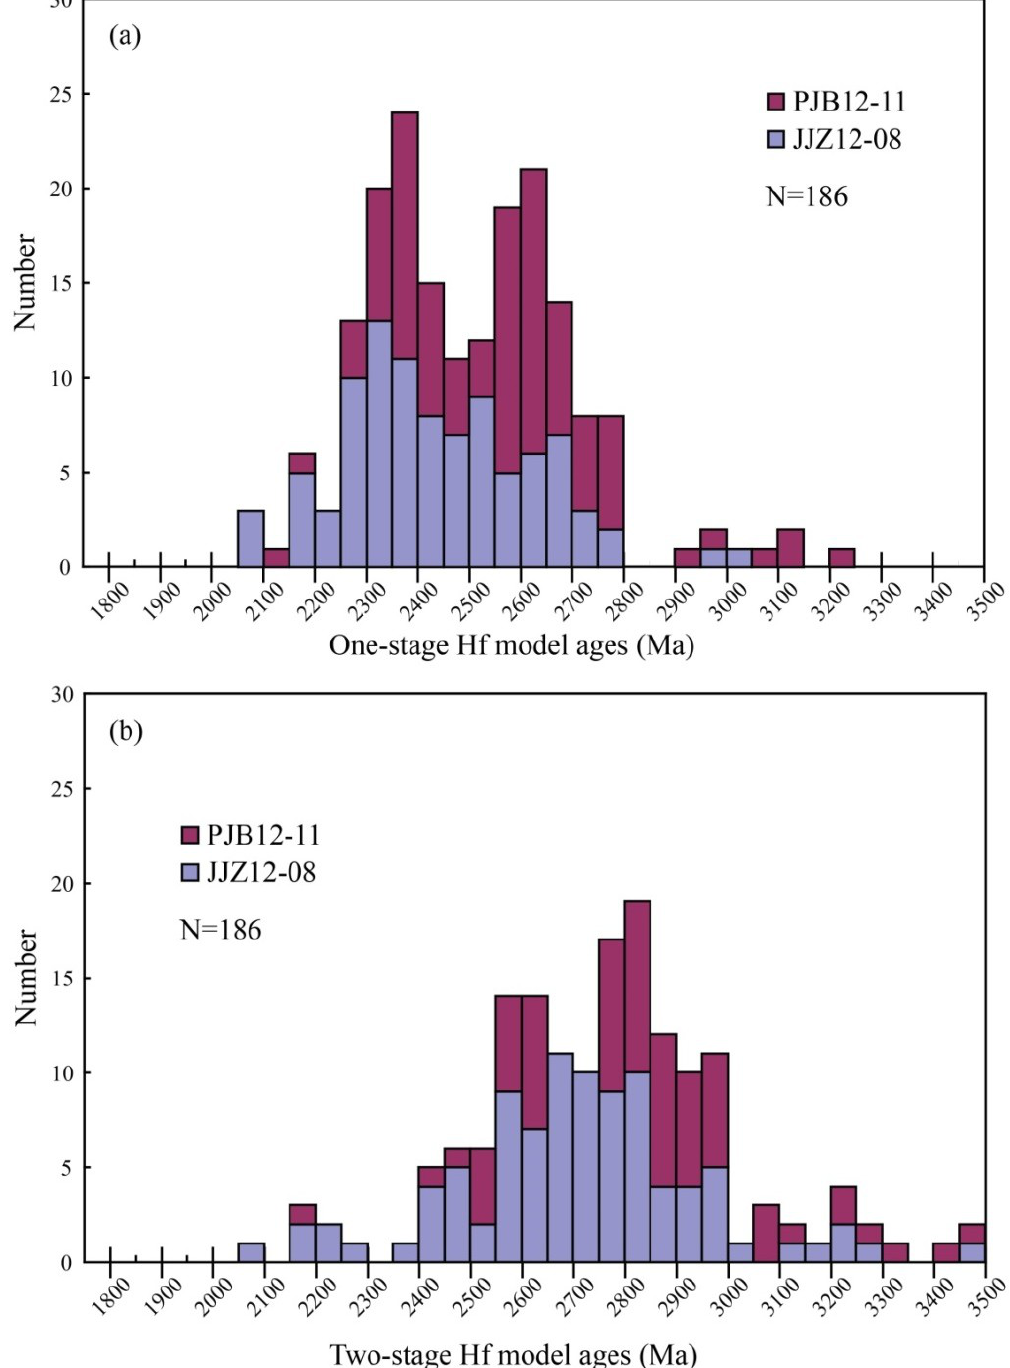
Figure 9. ( a ) Histogram of the one-stage Hf model ages of detrital zircon grains from JJZ12-08 and PJB12-11; ( b ) Histogram of the two-stage Hf model ages of detrital zircon grains from JJZ12-08 and PJB12-11.